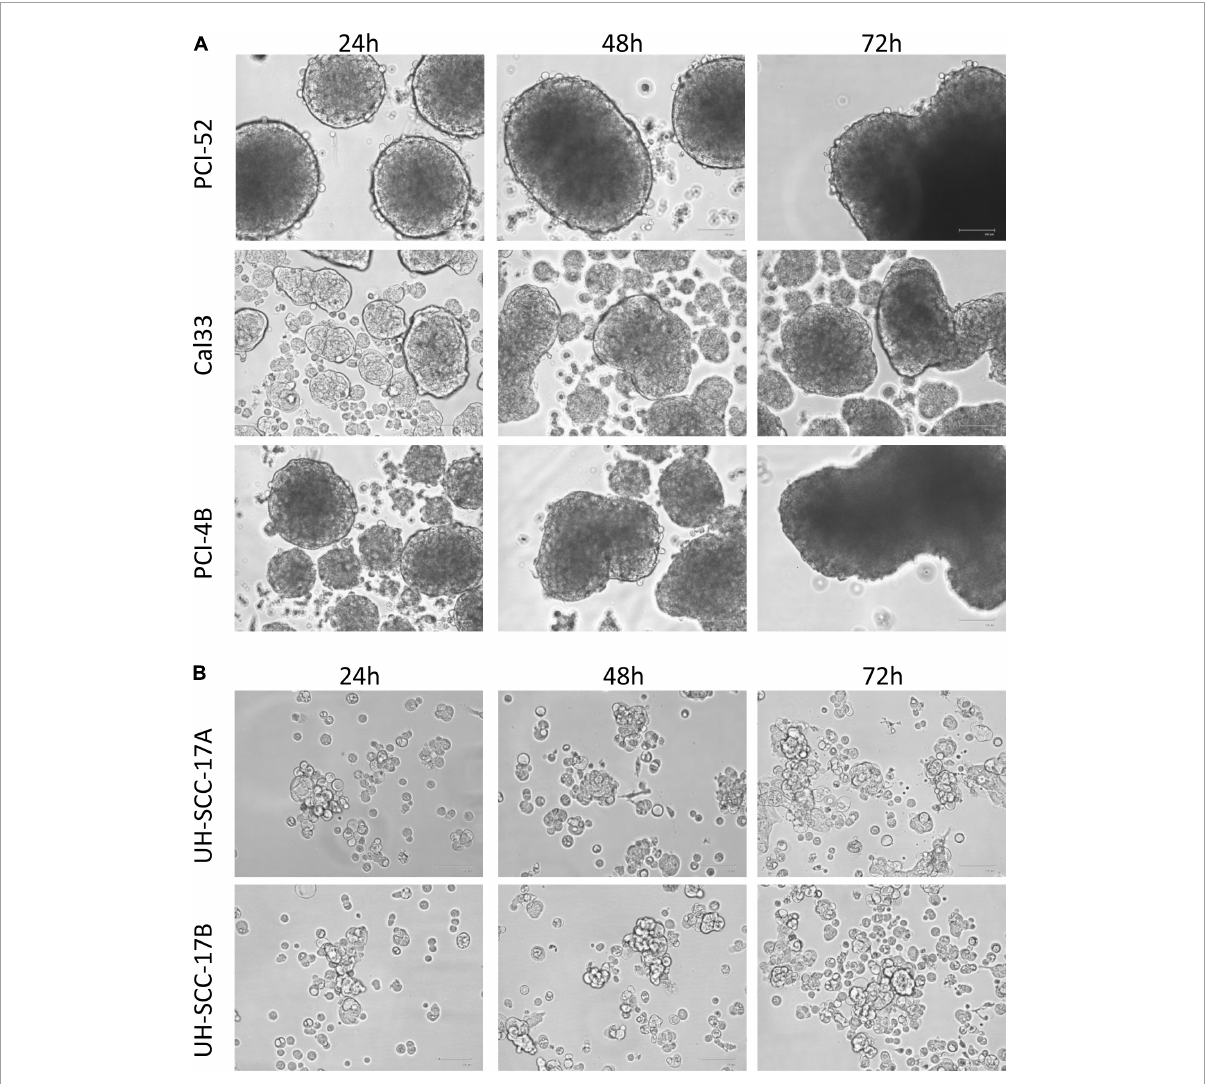
FIGURE2 Distinct 3D morphology of head and neck squamous cell carcinoma (HNSCC) cell lines. Representative photos from three different HNSCC cell lines (A) and from short-term cultures of a primary and metastatic lesion (B) are shown demonstrating the different shape and size of multicellular tumor spheroid (MCTS) obtained from HNSCC cell lines. Magnification: 100 ×